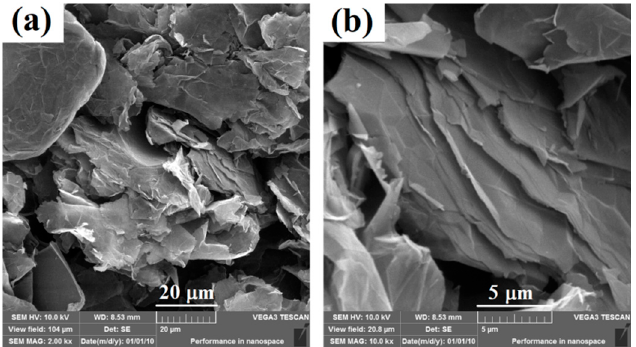
Figure 1. SEM images of graphene with ( a ) low resolution and ( b ) high resolution.